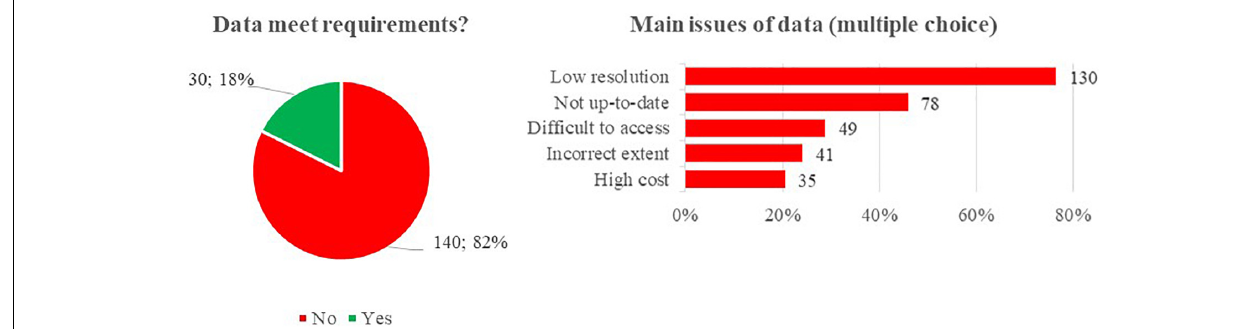
FIGURE 9 | Satisfaction of current data use.